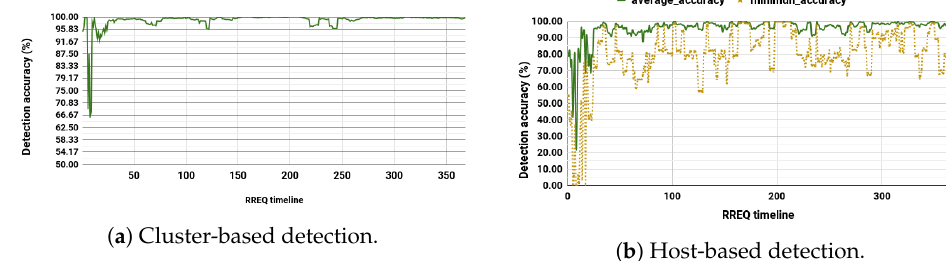
Figure 7. Cluster-based detection per RREQ timeline (Max speed of 4.3 m/s and Network of 50 nodes).